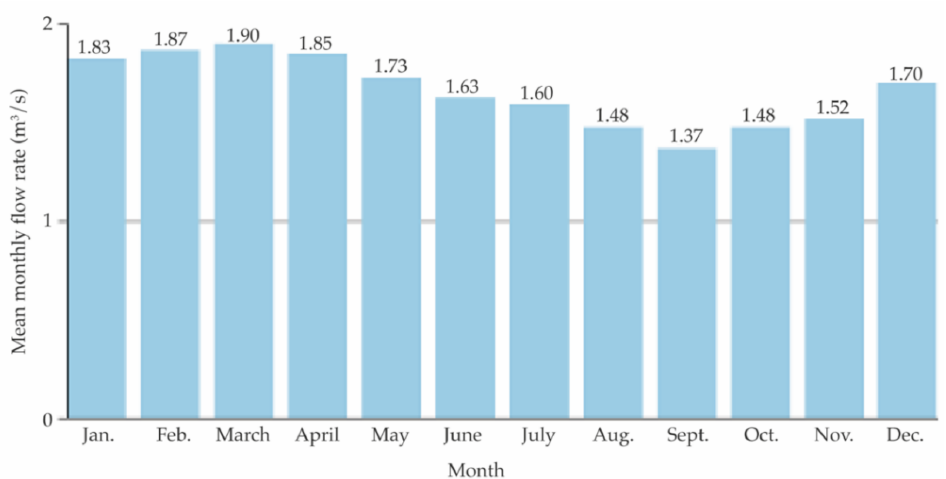
Figure 2. Mean monthly flow rate calculated over a 41-year period at Courteuil hydrological station, after